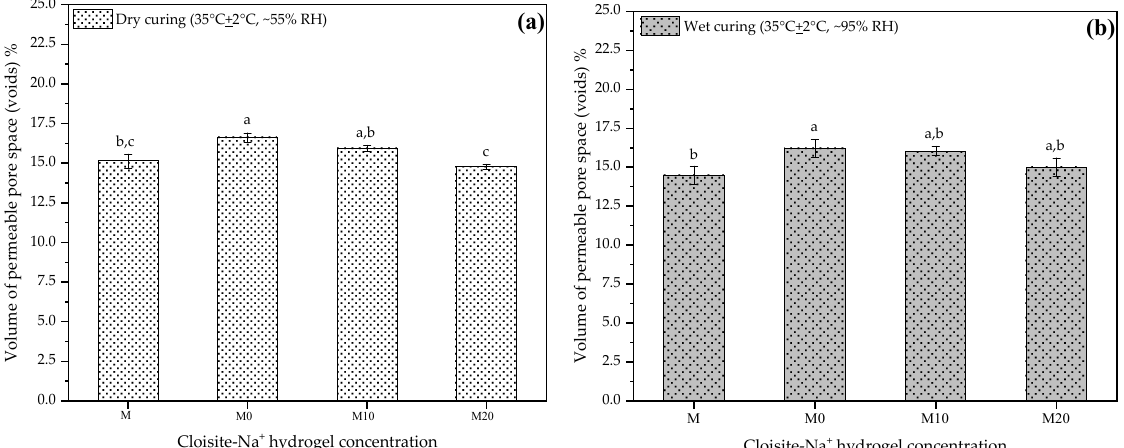
Figure 8. Volume of permeable pore space (voids) at 28 d to mortars produced with 0, 10, and 20% Cloisite Na + nanoclay hydrogels, in two different curing conditions ( a ) dry curing and ( b ) wet curing. Average with their respective standard deviation values, followed by equal letters do not differ statistically from each other following the Tukey test with a 95% confidence level.